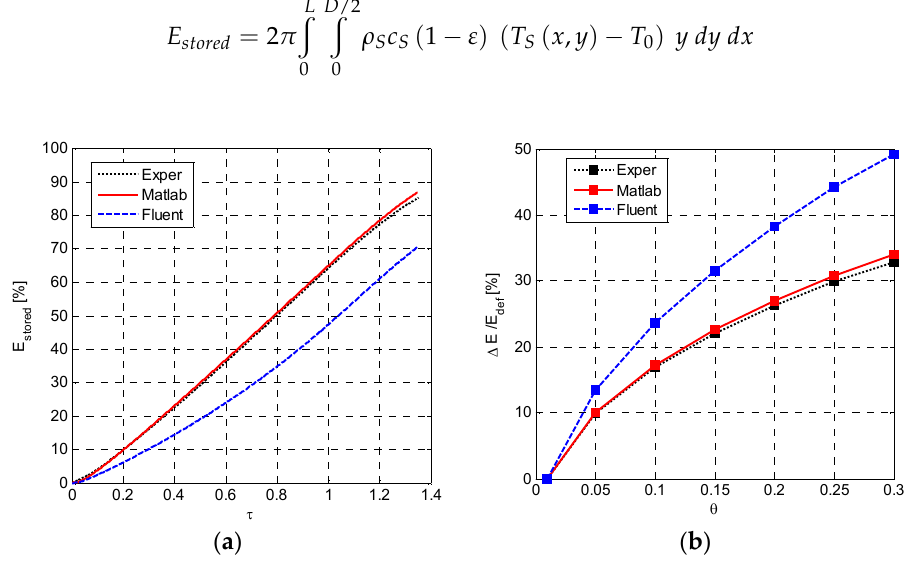
Figure 8. ( a ) Stored energy over maximum storable in % (Due to the radial temperature profile, the prediction of stored energy is overestimated when 1D model or experimental results are used); ( b ) Gain of stored energy for different values of θ at the outlet.